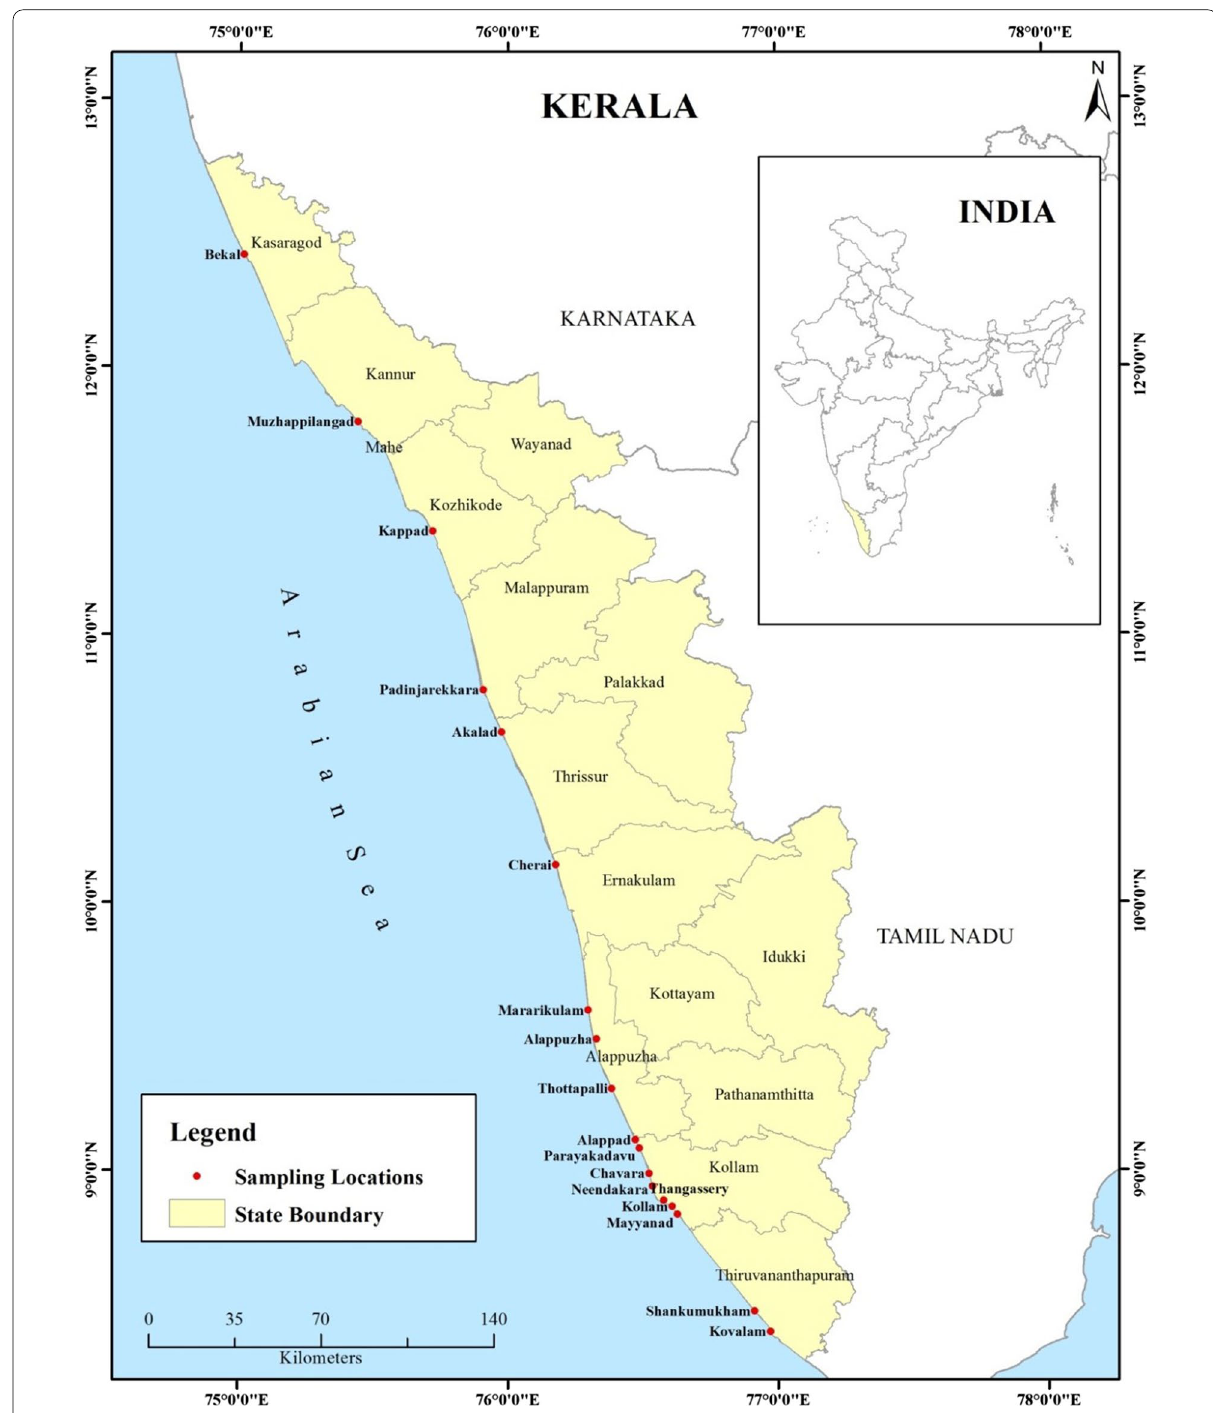
Fig. 1 Sampling locations along the coastal belt of